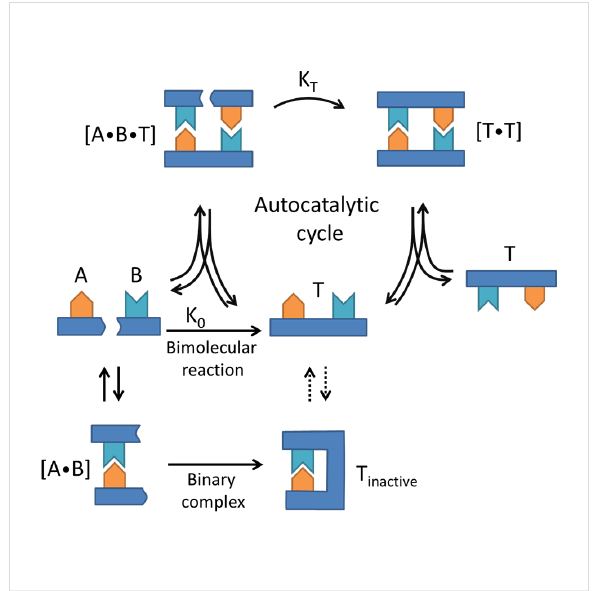
Figure 2: Minimal system for self-replication. Building blocks A and B can react to form either template T or its inactive counterpart T inactive . The formation of template T can direct A and B to a configuration in which they are in close proximity, accelerating the reaction between A and B leading to the formation of the [ T ∙ T ] complex. Dissociation of this complex completes the replication cycle of the initial template mole-